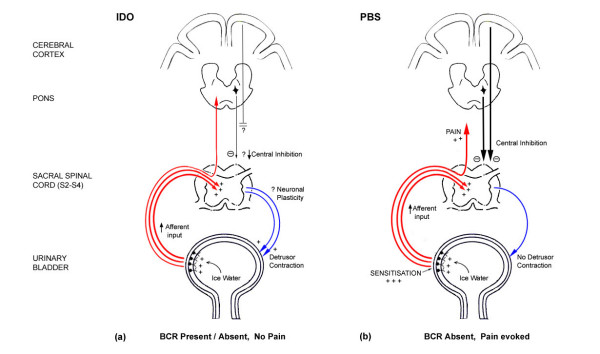
Mechanisms of the BCR and pain in overactive (IDO) and painful (PBS) bladders. Diagram of proposed mechanisms of the bladder cooling reflex and pain in patient sub-groups during the ice water test (IWT). In idiopathic detrusor overactivity (IDO) patients (a), a positive (IWT) may be a result of a loss of central inhibition and increased afferent activation, while the Pain evoked in Painful Bladder Syndrome (PBS) patients (b) may suggest sensitisation of increased afferents but preserved central inhibition.